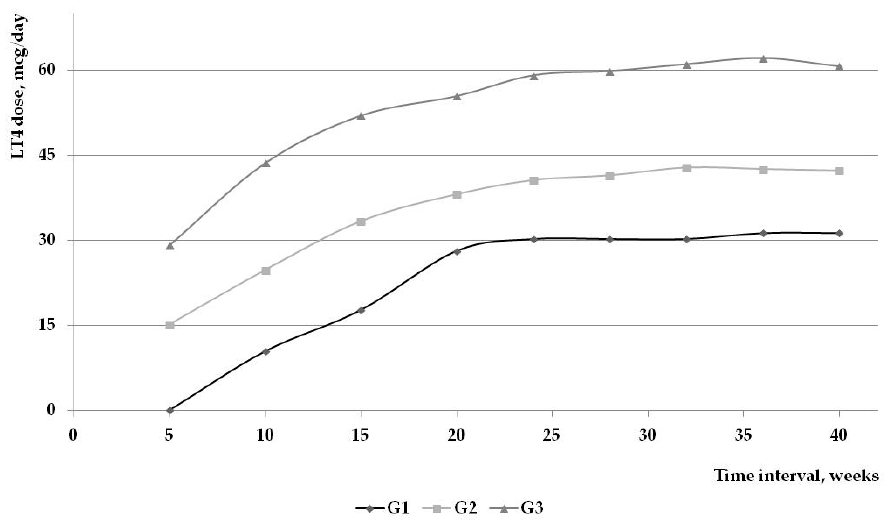
Figure 4. LT4 dose adjustments in the 3 subgroups.